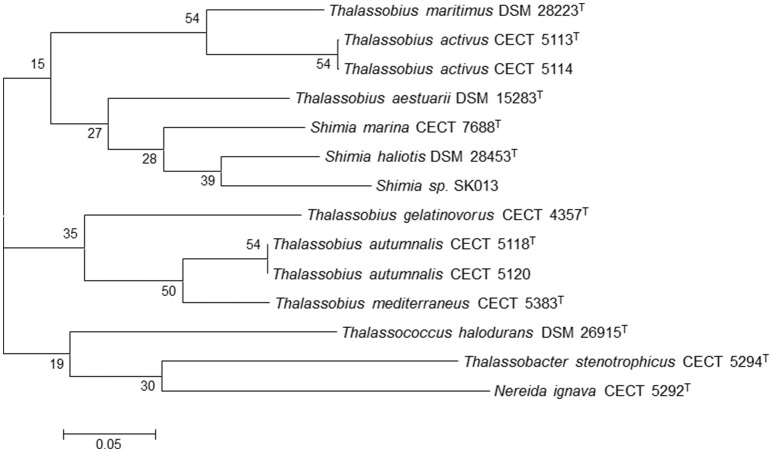
Phylogenetic tree generated with BCG54. Thalassobacter stenotrophicus CECT 5294T (CYRX01) and Nereida ignava CECT 5292T (CVQV01) were included as outgroup organisms. The numbers at the nodes indicate the gene support index (maximal value is 54).